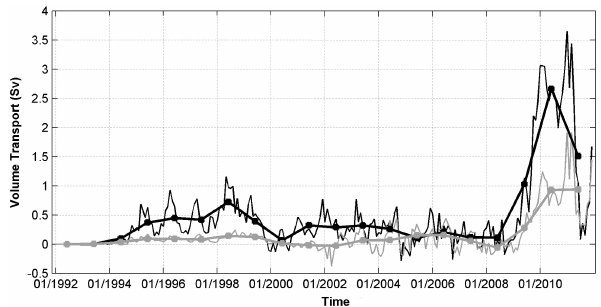
Figure 17. Annual (thick lines) and monthly (thin lines) ECCO2 volume transport in Section III of the AABW (black lines) and WSBW (gray